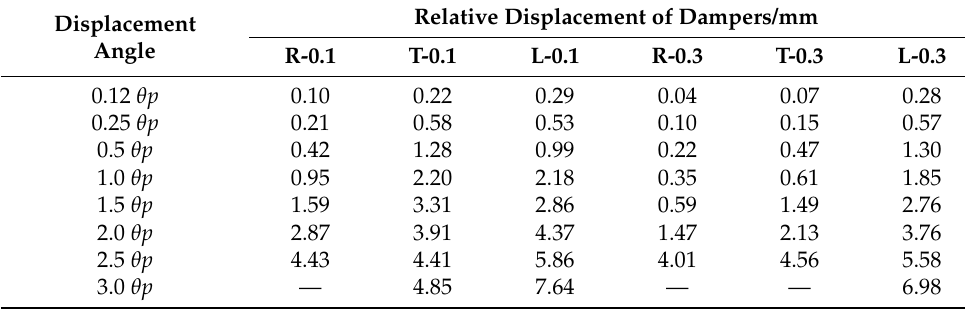
Table 9. Relative displacement of damper DX.